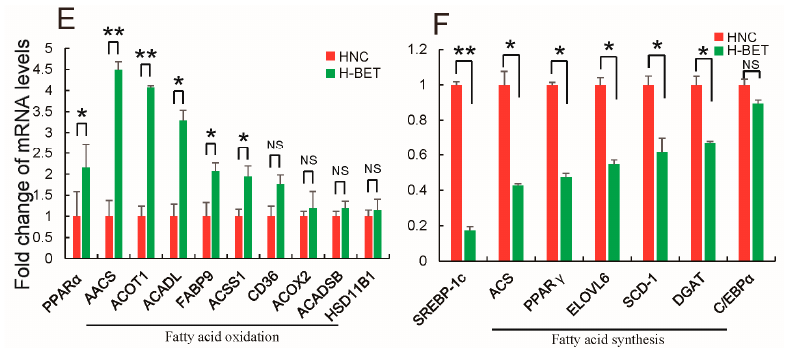
Figure 5. Betaine supplementation decreases intramyocellular lipid accumulation in high-fat diet (HFD)-induced obese mice. ( A ) Correlation between intramuscular fat contents and body weight, each point represents one mouse ( n = 58). Once mice fed with a HFD were treated with or without 1% betaine in water; ( B ) the authors stained lipid droplets in muscle tissues with oil red O (Scale bar, 10 µ m), and analyzed ( C ) intramuscular fat contents; ( D ) composition of intramuscular fatty acid (SFA, saturated fatty acid; PUFA, polyunsaturated fatty acids; MUFA, monounsaturated fatty acid), and the mRNA levels of genes associated with ( E ) fatty acid synthesis; ( F ) fatty acid oxidation in muscle tissues, these results are presented as means ± standard error (SE). n = 6. * p < 0.05; ** p < 0.01; NS, no significance; H-BET, mice fed with high-fat diet and betaine; HNC, mice fed with high-fat